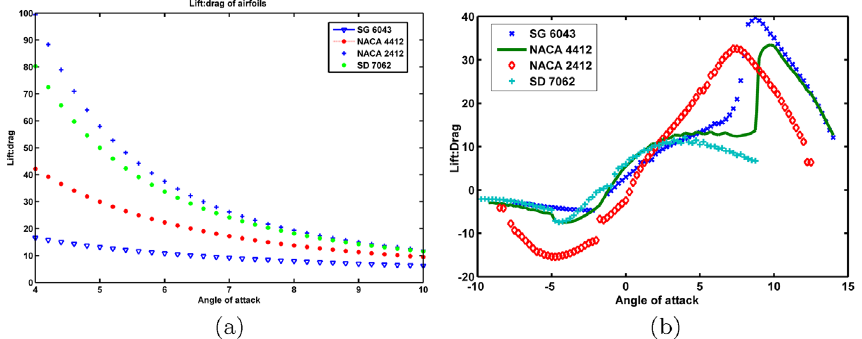
Figure 4. Lift:drag for SWT airfoil with varying (a) Theoritical; (b) Experimental approach at Re = 50,000 and Ncrit = 9.